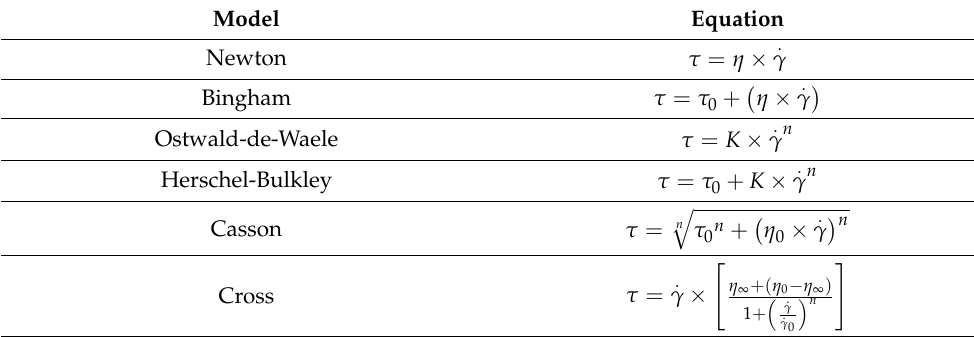
Table 6. Mathematical models for flow curve (shear stress ( τ ) versus shear rate (